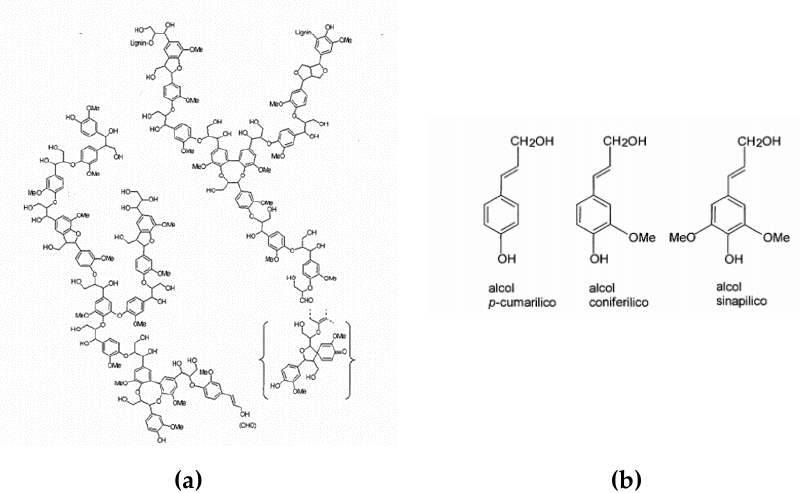
Figure 1. (a) Softwood Lignine structure according to Brunow, Sipila e Syrjanen. (b) On the right, Figure 1. ( a ) Softwood Lignine structure according to Brunow, Sipila e Syrjanen. ( b ) On the right, structure of the three Lignin’s precursors (°p-coumaryl alcohol, coniferyl alcohol, and sinapyl structure of the three Lignin’s precursors ( ◦ p-coumaryl alcohol, coniferyl alcohol, and sinapyl alcohol).